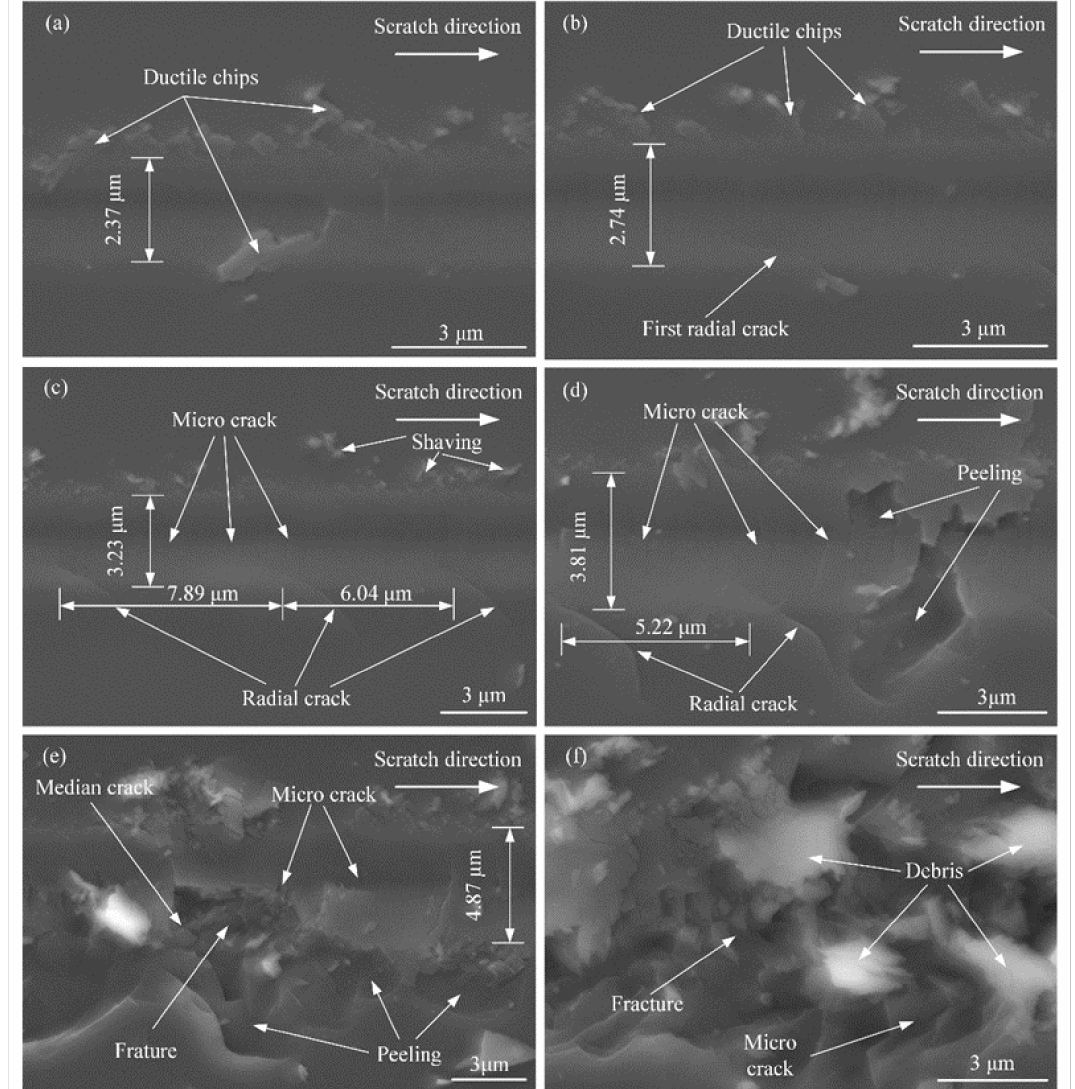
Figure 12. Surface morphologies of cracks and damages with di ff erent lateral displacements: ( a ) lateral displacement ranging from 128 to 134 µ m, ( b ) lateral displacement ranging from 171 to 177 µ m, ( c ) lateral displacement ranging from 220 to 238 µ m, ( d ) lateral displacement ranging from 290 to 294 µ m, ( e ) lateral displacement ranging from 430 to 444 µ m, and ( f ) lateral displacement ranging from 556 to 570 µ